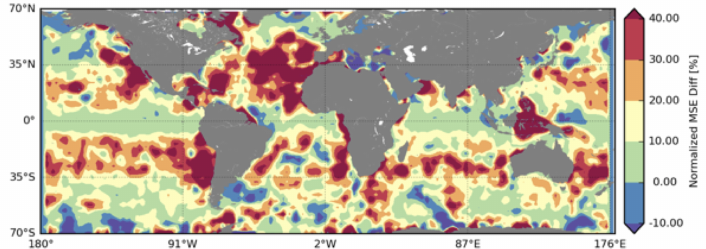
Figure 8. Normalized Mean Square forecast Error difference in percentage between the experiments assimilating three and four altimeter data sets under CryoSat-2, Jason-2 and HY-2A tracks with the 1/12 ◦ global system: (innov 3 alt) 2 − (innov 4 alt) 2 / (innov 3 alt) 2 − SARAL/AltiKa being the fourth